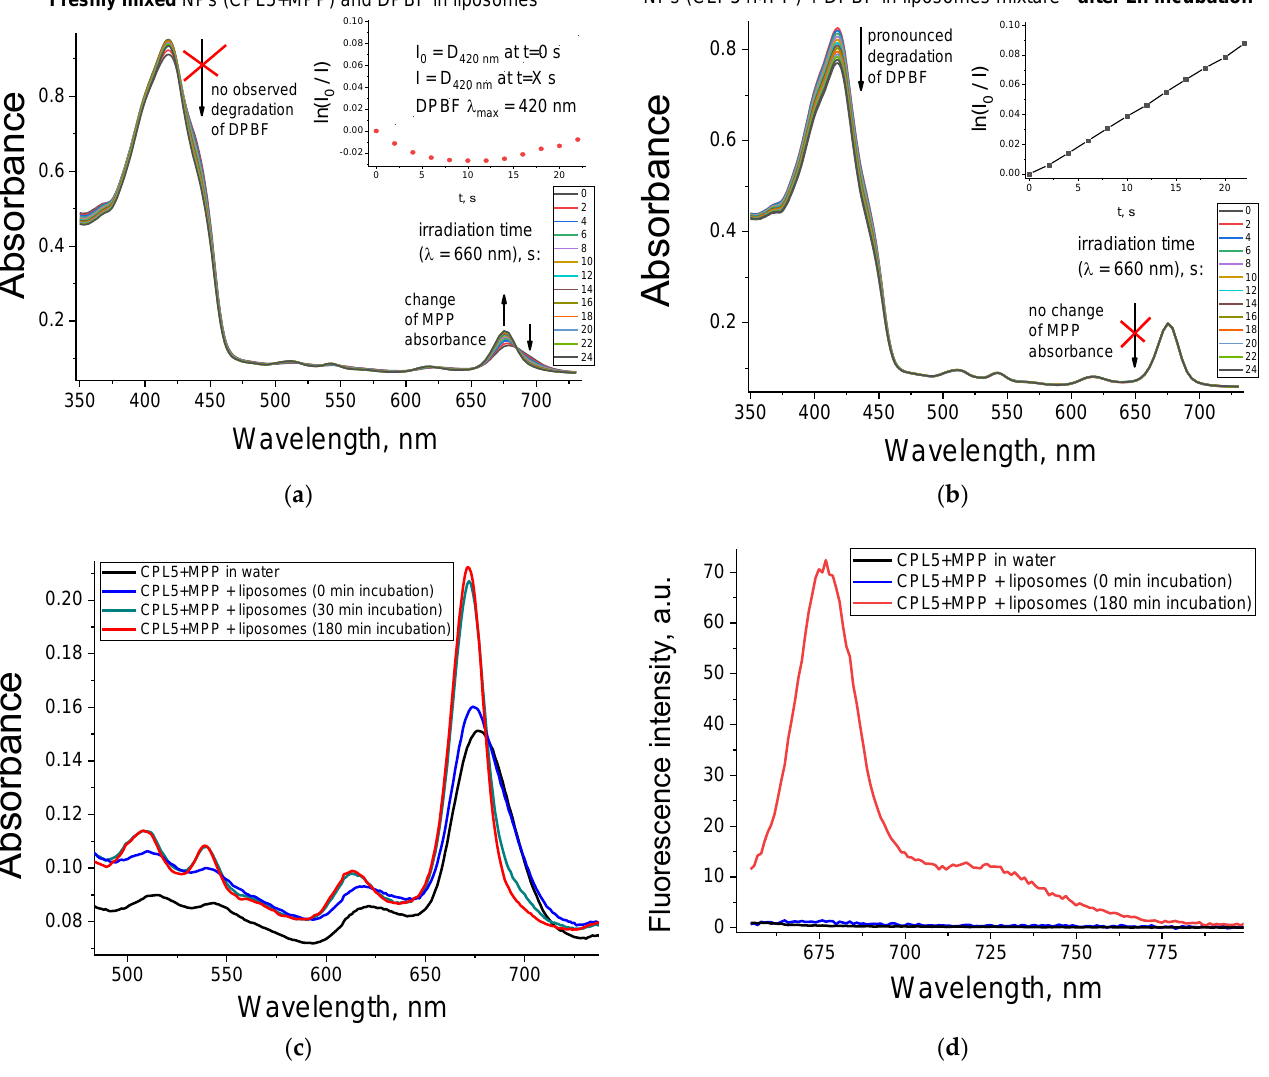
Figure 6. Interaction of CPL5 + MPP NPs with liposomes: absorption spectra of mixture for detection of singlet oxygen generation (DPBF probe encapsulated in lecithin liposomes) — freshly prepared ( a ) and after 2 h of incubation ( b ). The mixture of water solution of CPL5 + MPP immediately after addition to the lecithin liposomes solution (0 min) and after a certain incubation time (displayed in the legend) — absorption ( c ) and fluorescence spectra ( d ).